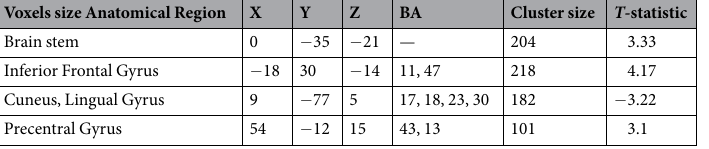
Table 2. Brain regions with significant volume variation in schizophrenics with tardive dyskinesia group compared to schizophrenics without tardive dyskinesia group. X, Y, Z: MNI (Montreal Neurological Institute) coordinates;